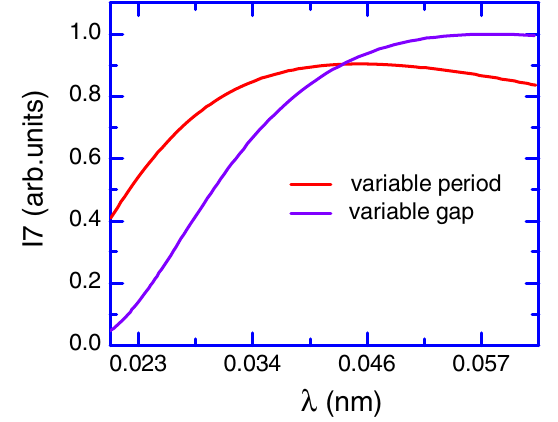
FIG. 10. The spectral intensities of the seventh harmonics.